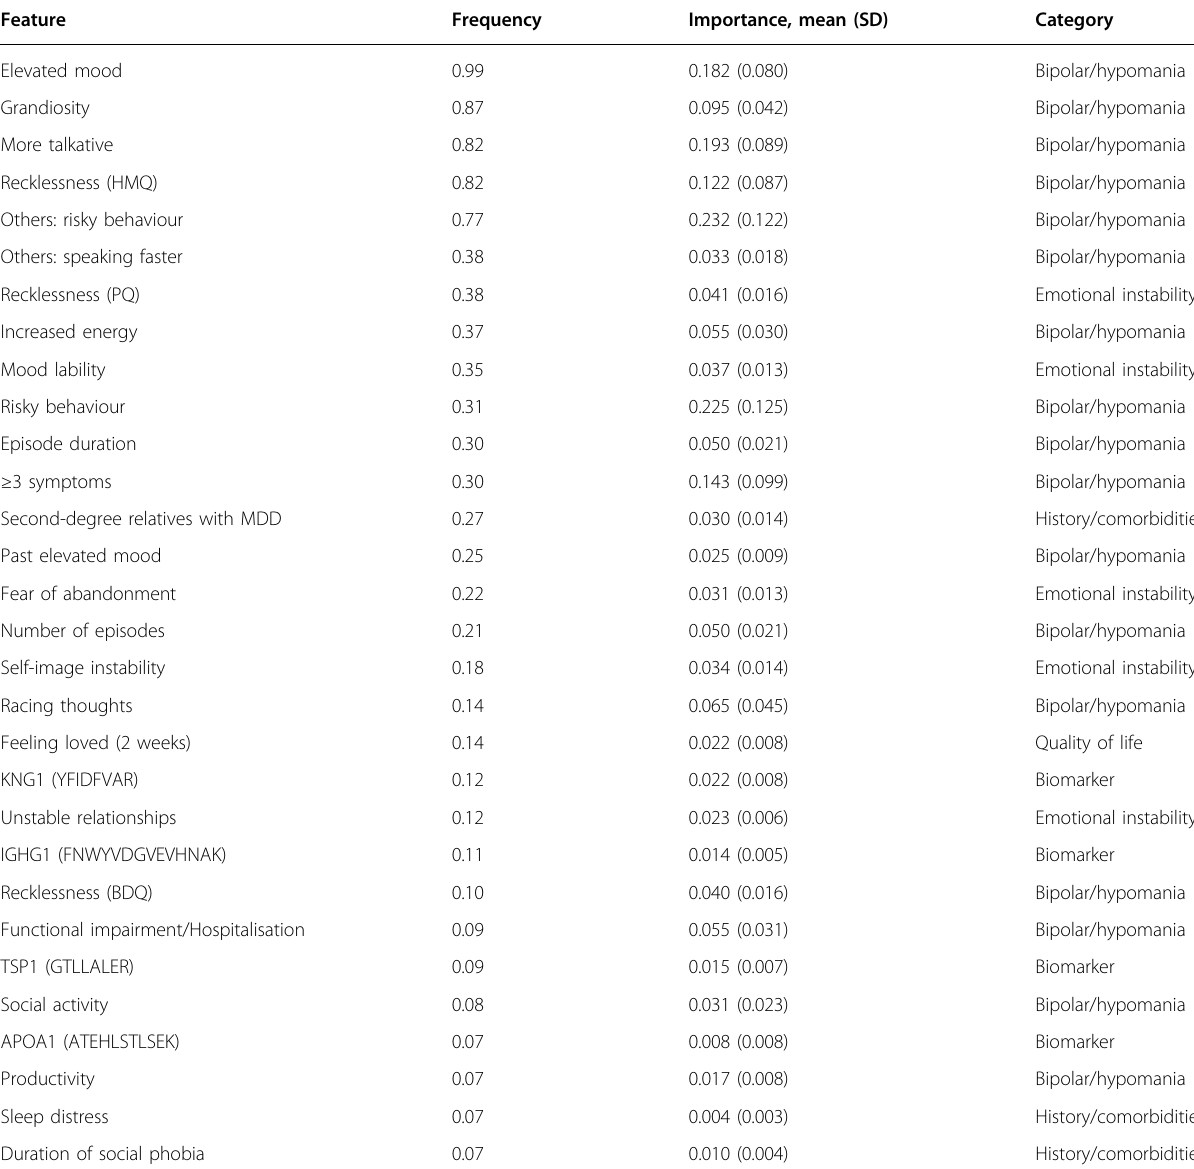
Table 3 Top predictors of bipolar